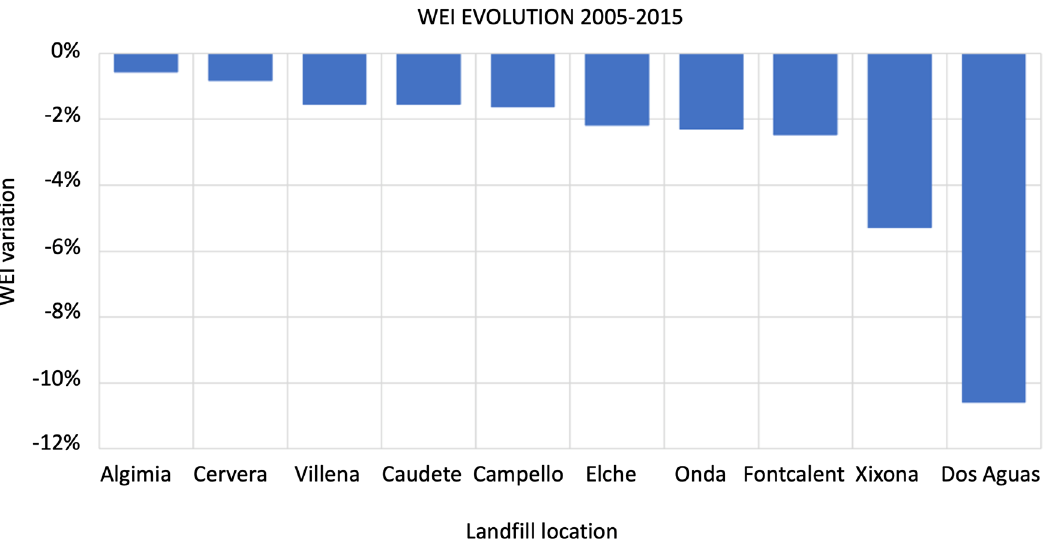
Figure 5. WEI evolution between 2005 and 2015 for every landfill.